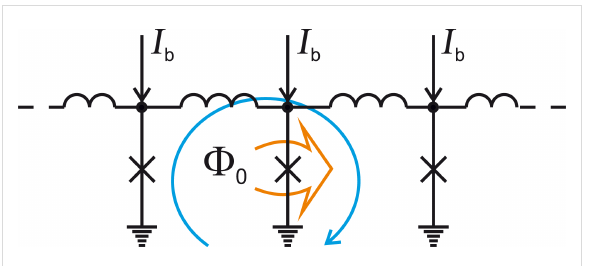
Figure 2: Josephson transmission line. Josephson junctions are shown by crosses. I b is the applied bias current. The blue arrow presents an SFQ circulating current. The orange arrow highlights the Josephson junction in the resistive